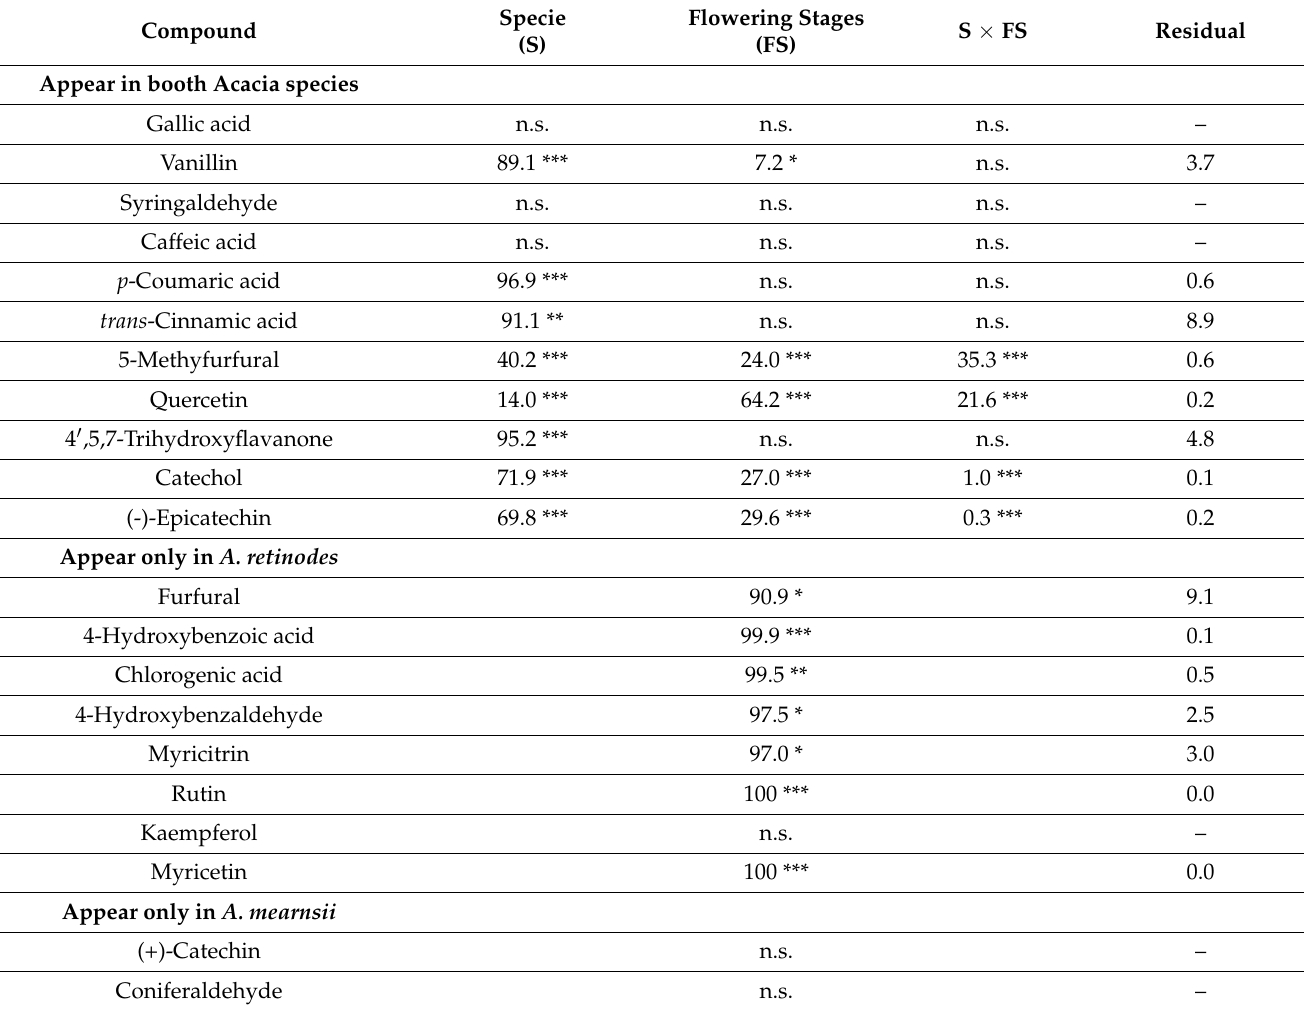
Table 4. Variance percentages were obtained in a two-way ANOVA performed for all analysed compounds concerning Acacia flowers from two species and two flowering stages.